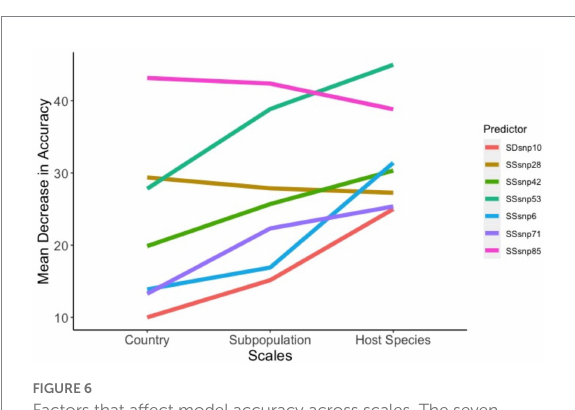
FIGURE 6 Factors that affect model accuracy across scales. The seven regions between the ‘across-scales model’ that increase or decrease the model accuracy as the scales move from general (Country of origin) to less specific (Host